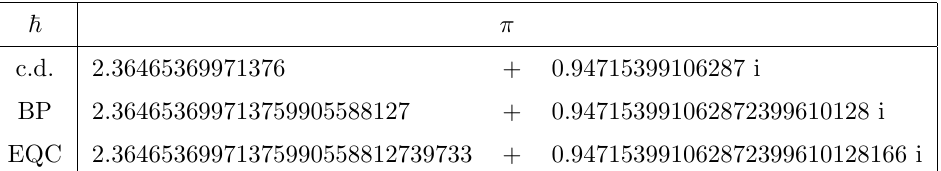
= 2 log(2) + (cid:25) i and ~ = (cid:25) 0